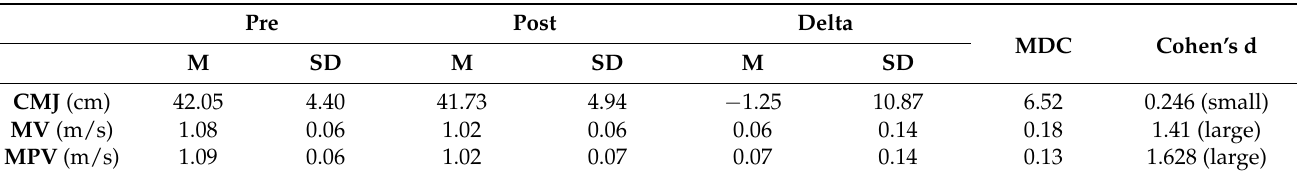
Table 2. Descriptive statistics (mean and standard deviation) for countermovement jump, mean velocity and mean propulsive velocity variables during pre- and post-measures.